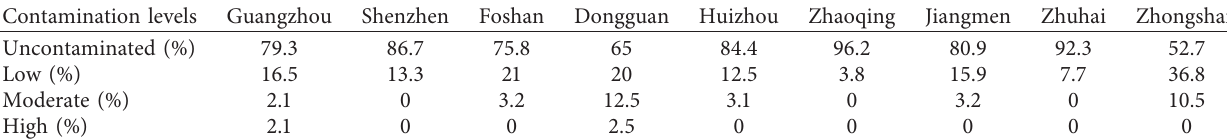
Table 3: Groundwater salinity contamination in various cities in the Pearl River Delta.